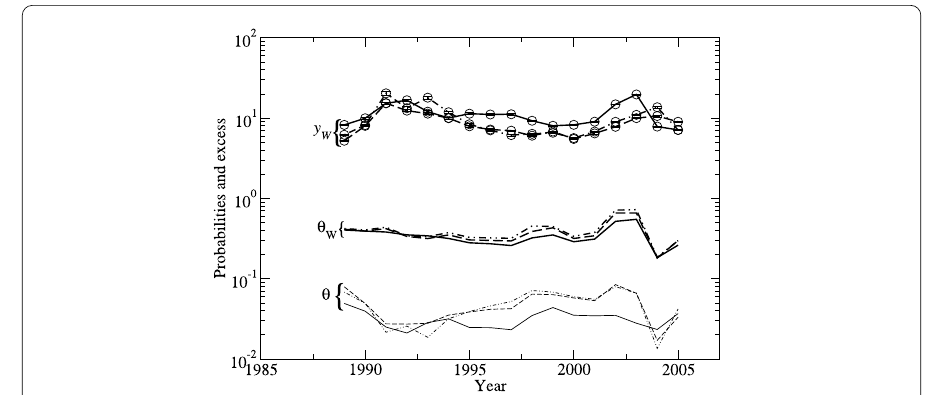
Figure 12 The fractions θ ( t , (cid:2) t ) and θ W ( t , (cid:2) t ) and the excess probability y ( HF ) W ( t , (cid:2) t ), where (cid:2) t = 2 with the following symbol code: (—) lines represent W = 1, (– · · –) lines represent W = 2, (– – –) lines represent W = 3; thin lines represent θ ( HF ) ( t , (cid:2) t ), thick lines represent θ W ( t , (cid:2) t ), and thick lines with ◦ represent y ( HF ) W ( t , (cid:2) t ). The brackets signal the location of θ ( t , (cid:2) t ), θ W ( t , (cid:2) t ), and y ( HF ) W ( t , (cid:2) t ) in the plot